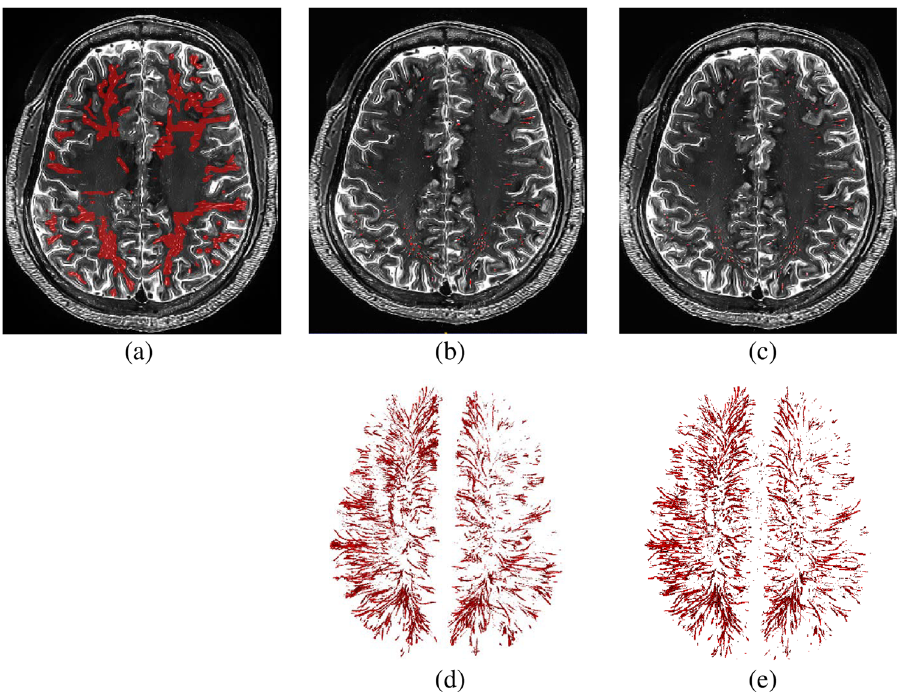
Figure 7. ( a ) The manually drawn ROIs of PVSs (red regions), ( b ) the ground-truth labels (red thin line structures) generated by intensity hard-thresholding upon the ROIs, followed by manual editing via two experts, ( c ) the same image with our PVS segmentation results (red thin line structures), ( d ) the 3D rendering of ground-truth labels, and ( e ) the 3D rendering of our PVS segmentation